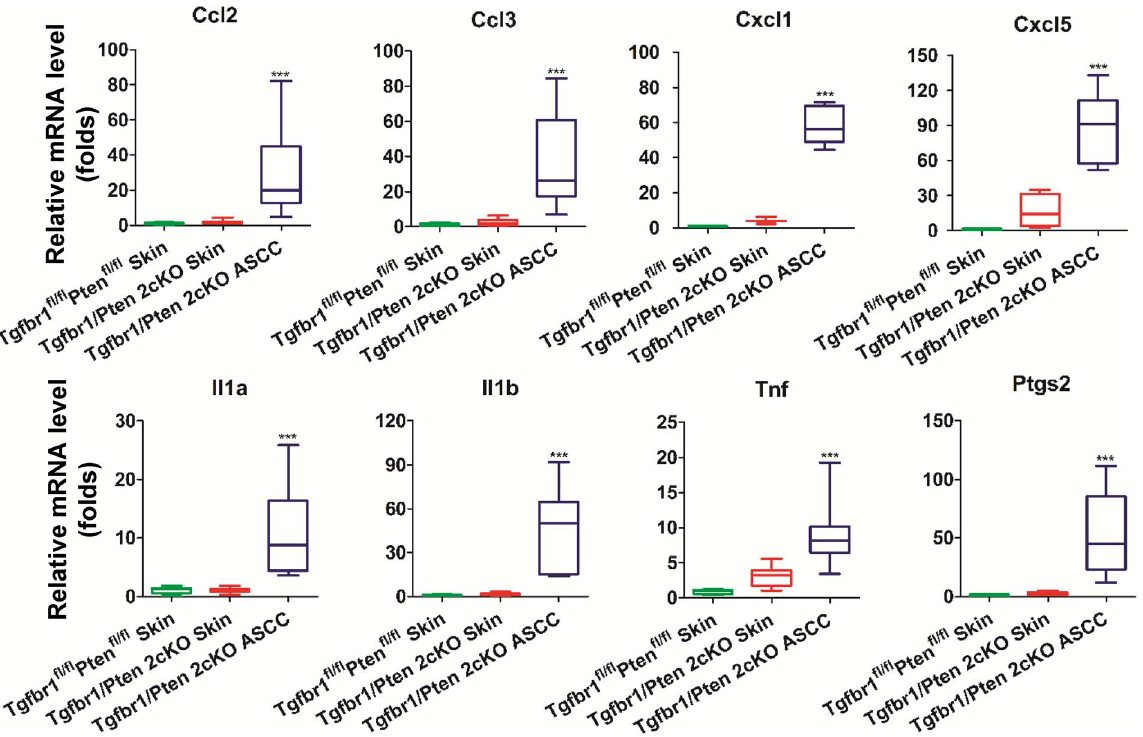
Figure 4. Increased levels of pro-inflammatory cytokine in Tgfbr1/Pten 2cKO mice ASCC. Real-time PCR analysis shows increased expression of Ccl2, Ccl3,Cxcl1,Cxcl5,Il1a,IL1b,Tnf,Ptgs2 in Tgfbr1/Pten 2cKO mice ASCC compared with Tgfbr1 flox/flox /Pten flox/flox anal skin and Tgfbr1/ Pten 2cKO anal skin. n=5 in each group, Mean 6 SEM; ***, P , 0.001: One-way ANOVA with post-Dunnett test.